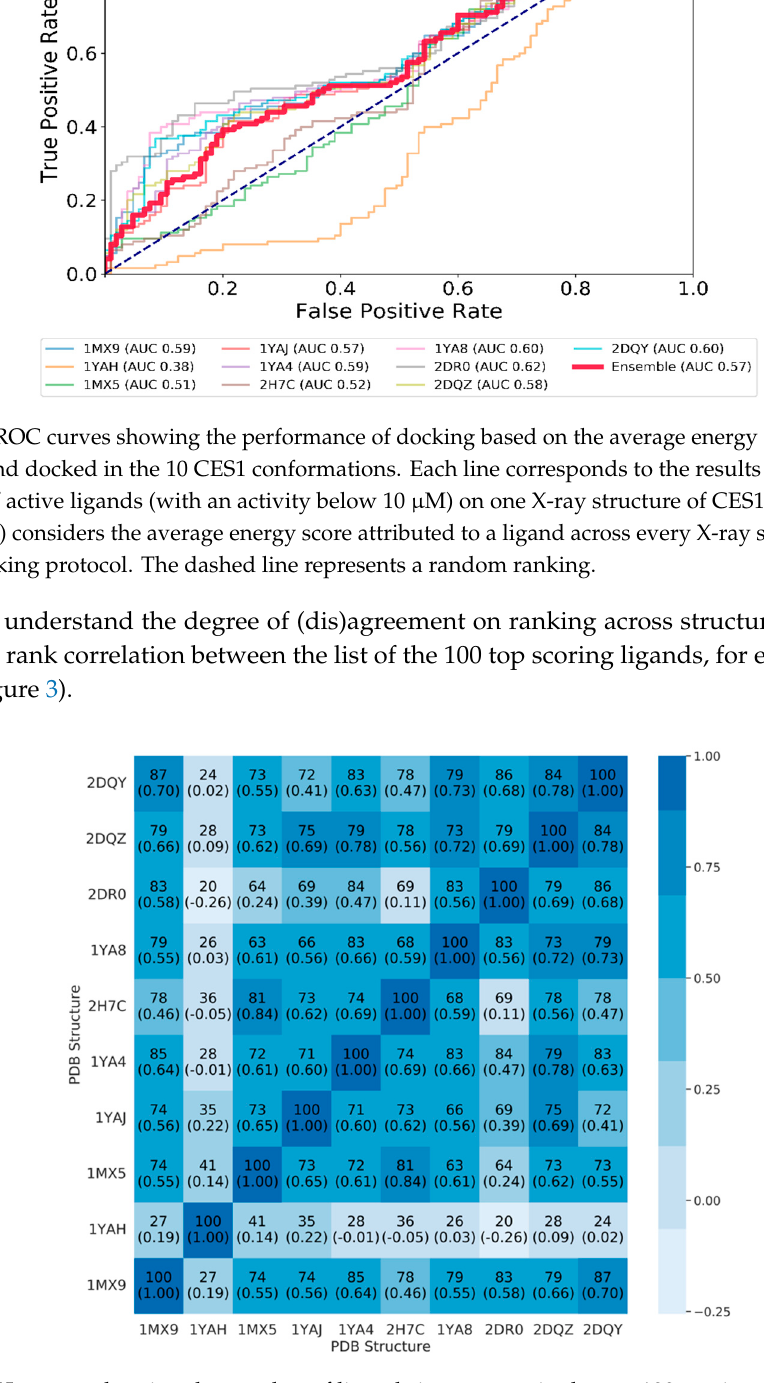
Figure 3 . Heatmap showing the number of ligands in common in the top 100 scoring molecules for each pair of structures, and the Spearman R rank correlation for these ligands according to docking scores (in parenthesis). Color corresponds to Spearman R value.